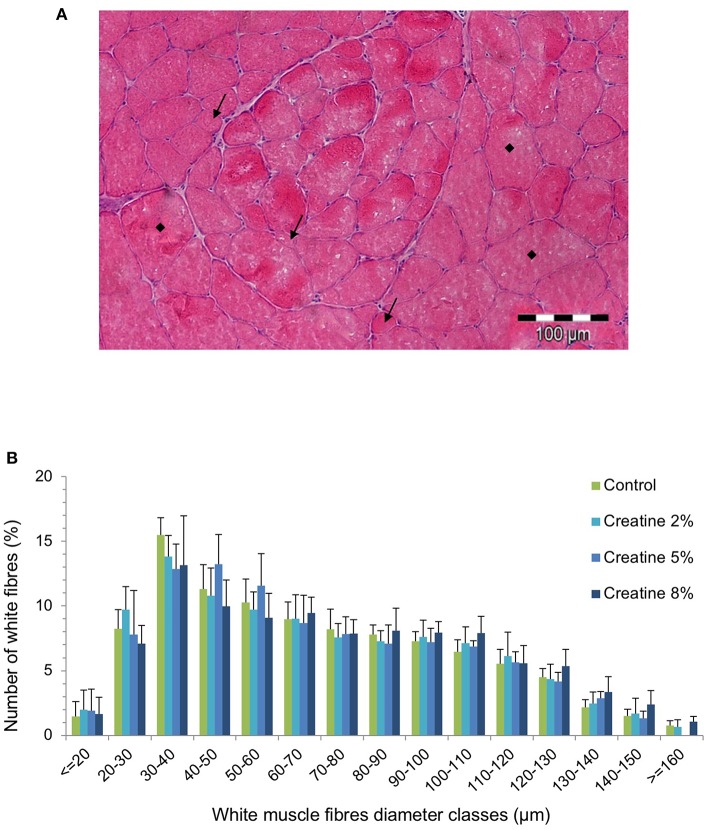
Cross section of skeletal white muscle in a juvenile gilthead seabream fed 5% Creatine diet, showing newly (i.e., small [arrow]) recruited muscle fibers between older (i.e., large ■) muscle fibers (A), and white muscle fiber diameter classes of juveniles fed juveniles fed the experimental diets for 69 days (n > 700 fibers) (B). Error bars indicate the standard error of the mean for each treatment (n = 6).